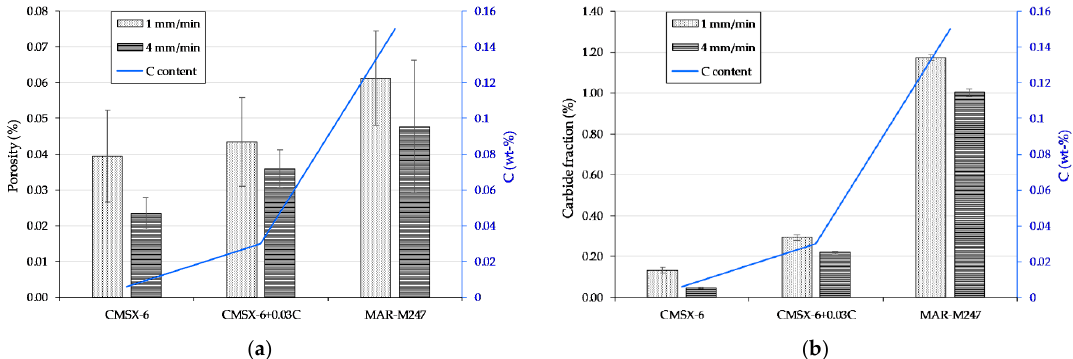
Figure 4. Dependence of carbon content on the ( a ) shrinkage porosity and ( b ) carbide fraction of single crystal part of the samples directionally solidified at different rates.